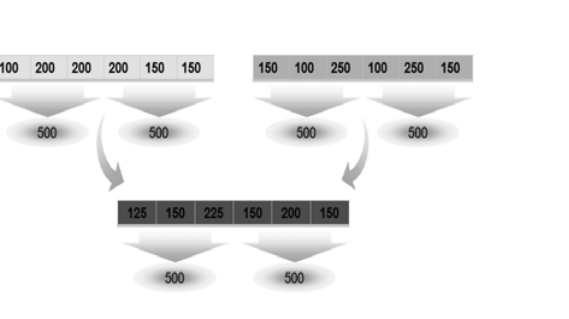
Fig. 1. Details of crossover Fig. 2. Details of